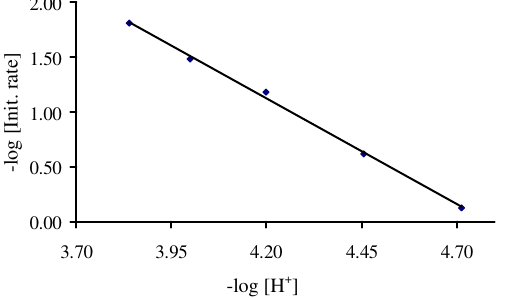
Figure 5. Plot of log [Initial rate] vs . log [H + ] at λ [Fe 3+ ] = 1 x 10 -4 M, [Cysteine] = 2 x 10 -4 M, 10% ethanol and pH = 3.8 - 4.7